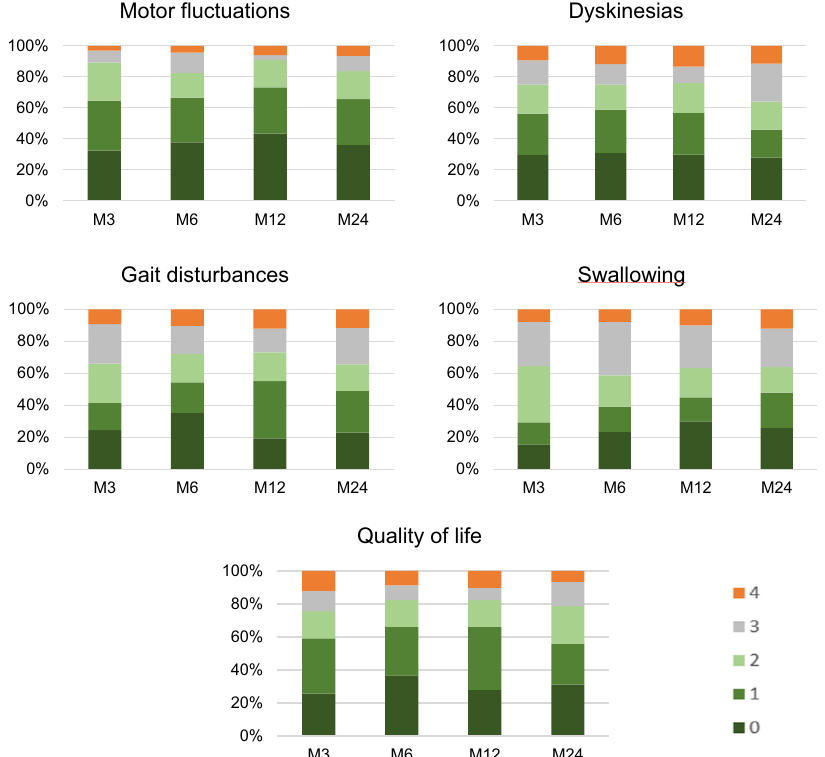
Fig. 3 Satisfaction self-assessment questionnaire. Histograms illustrating the proportion of patients for each score on the fi ve items of the treatment satisfaction self-questionnaire. Motor fl uctuations was the item with the largest percentage of patients stating improvement (83 – 91%). Quality of life was improved in 76 – 82% of patients and dyskinesias in 64 – 76%. Gait and swallowing disturbances showed a more modest percentage (60 – 73%). 0 = very much improved, 1 = moderately improved, 2 = little improved, 3 = not improved, and 4 =